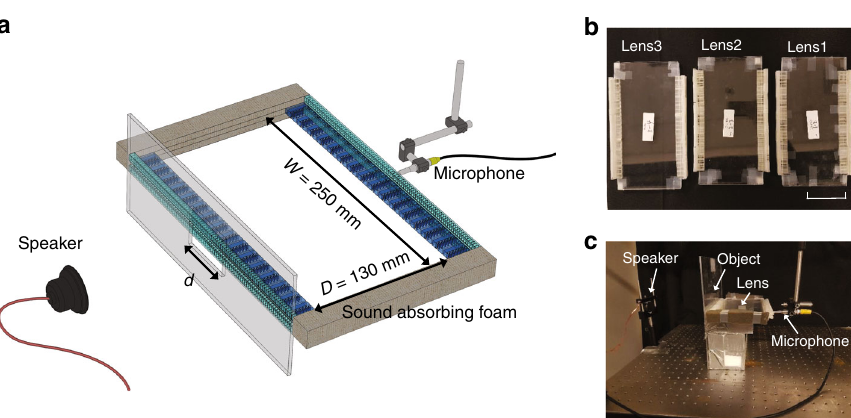
Fig. 5 Experimental setup. a Experimental setup for subwavelength imaging and edge detection of 1-D slits. The speaker is 20 cm away from the lenses. The objects are 1-D slits put at the entrance of the transmitter. A microphone is used to scan the signal distribution at the exit of the receiver. b 3D printed lens1, lens2 and lens3. The white scale bar on the right bottom represents the length of 100 mm. c A photo of the